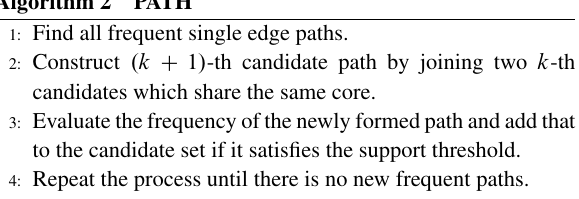
Fig. 8 Example graphs [17] .